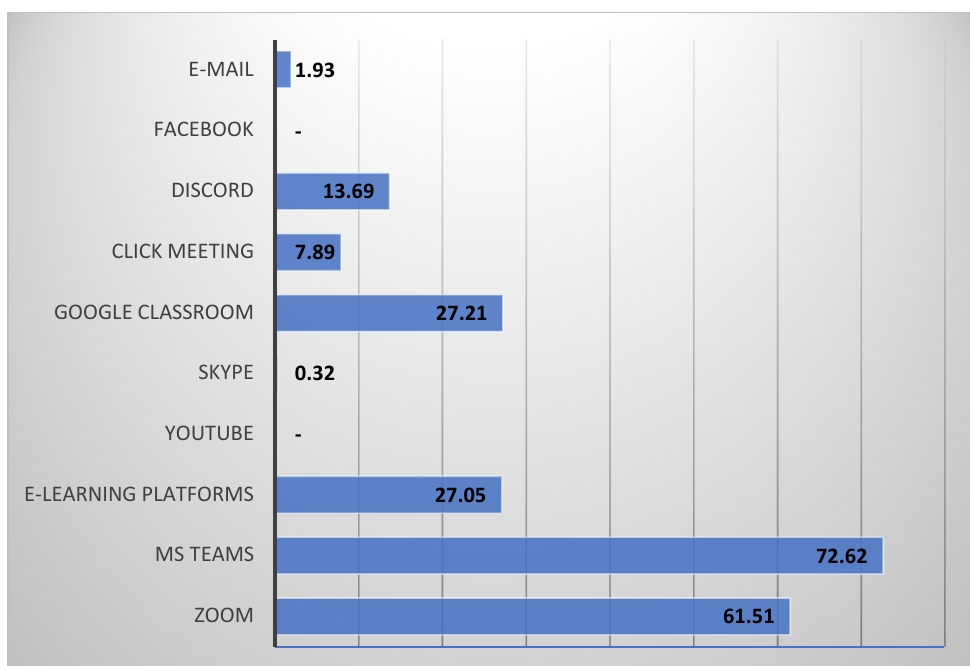
Figure 2. Percentage of students familiar with a given e-learning tool—currently.